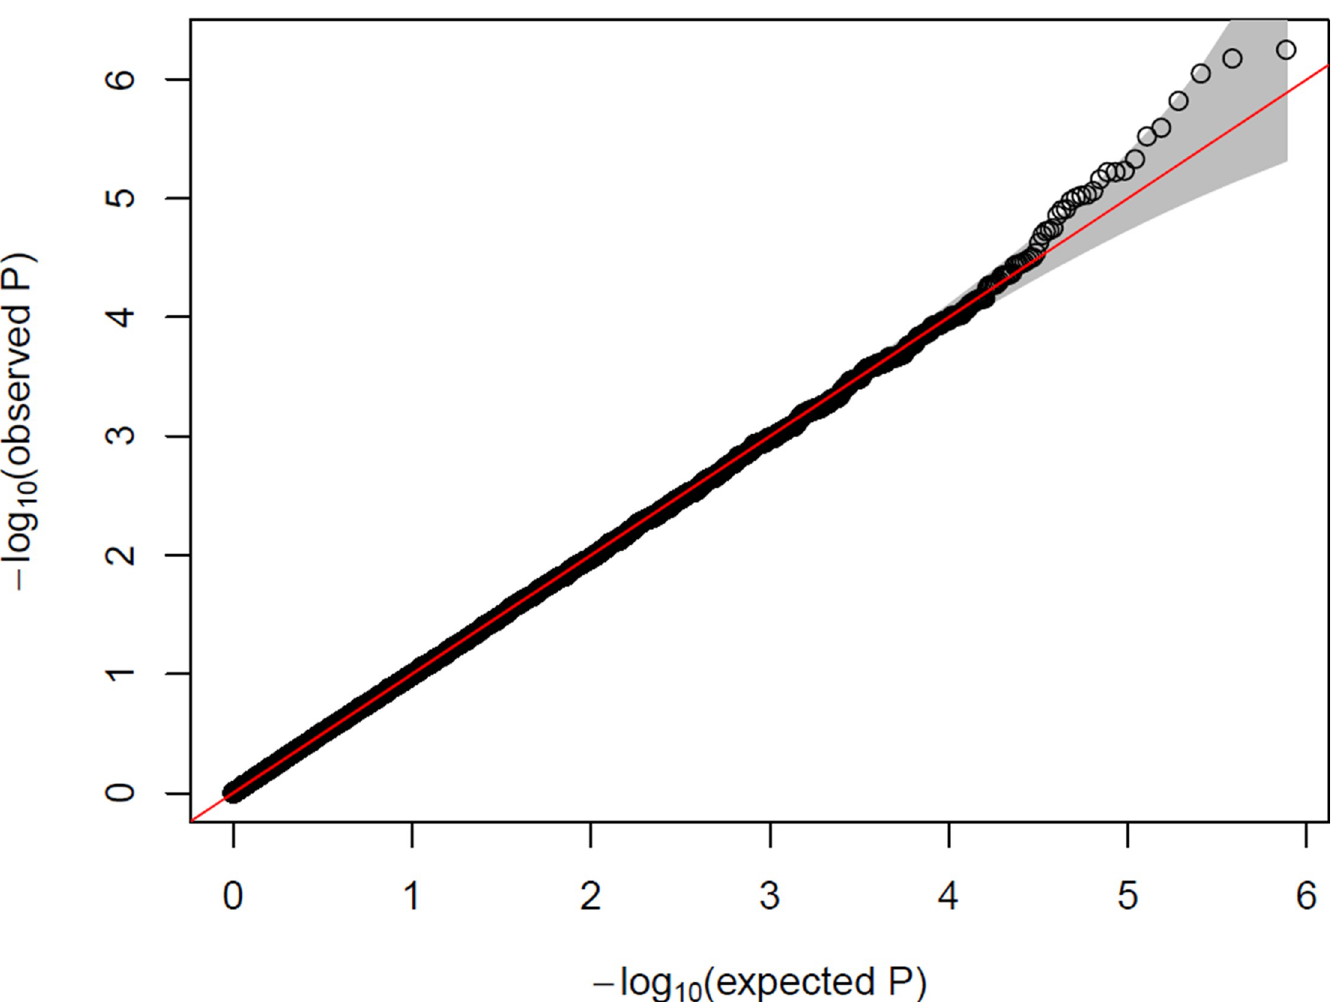
Fig 2. A quantile-quantile plot indicating association p -values between 767,207 single nucleotide polymorphisms and case/control status of contralateral breast cancer. The gray area indicates the 95% confidence interval of the normal distribution.